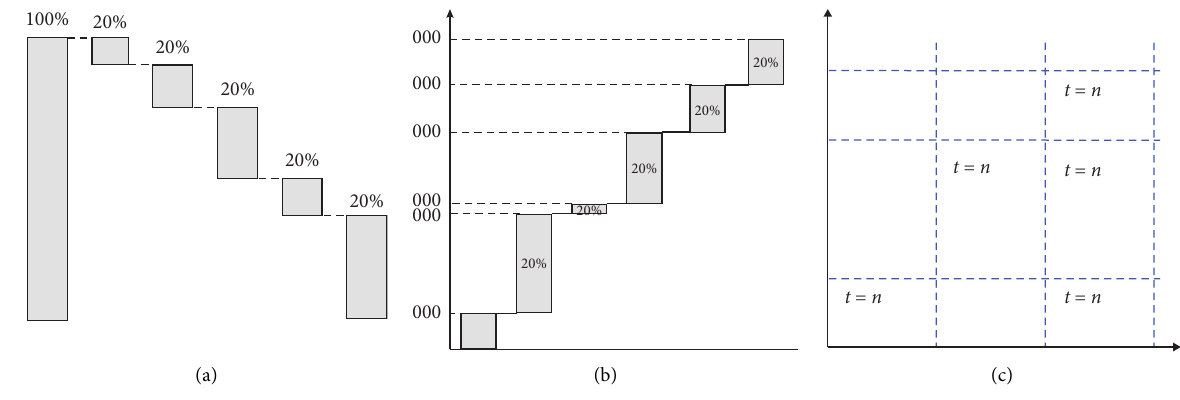
Figure 5: The identification